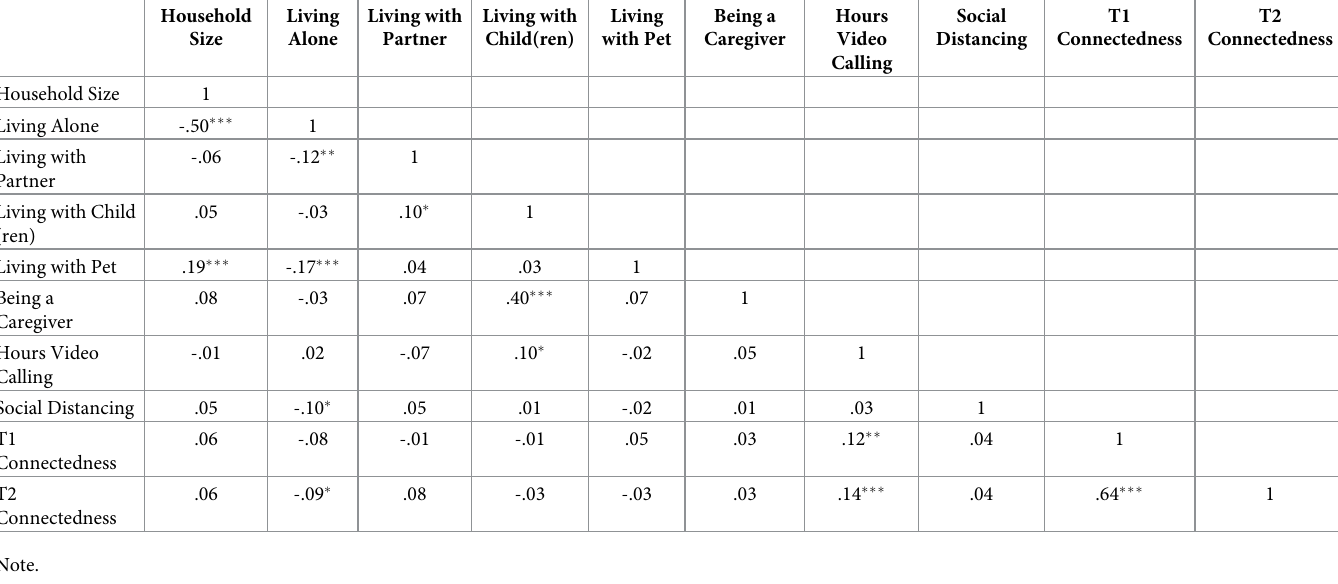
Table 1. Correlations among variables (Study